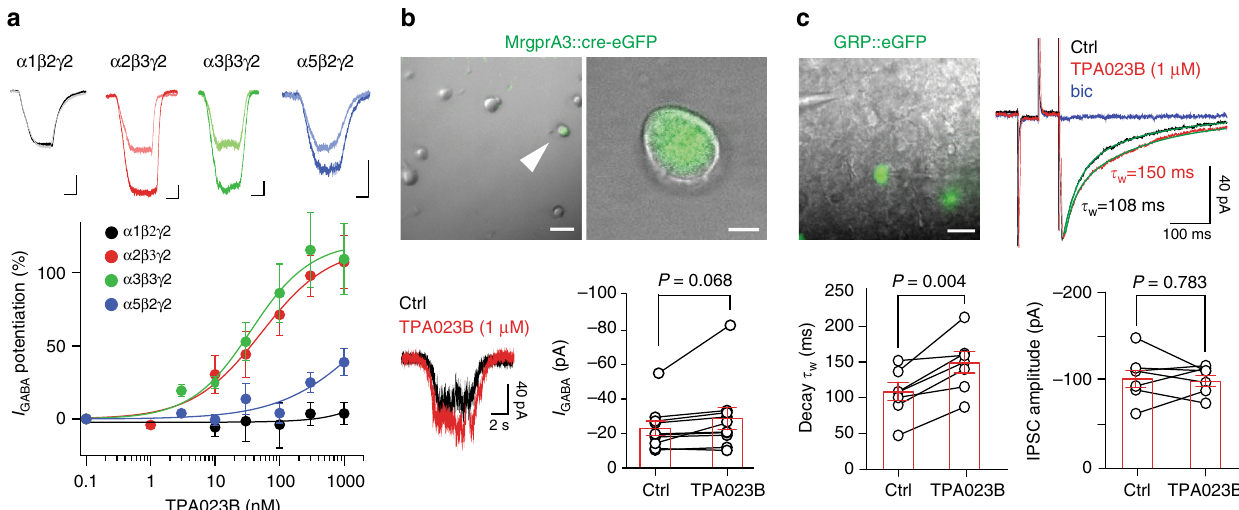
Fig. 4 In vitro pharmacological pro fi le of TPA023B. a Positive allosteric modulation by TPA023B of α 1 β 2 γ 2, α 2 β 3 γ 2, α 3 β 3 γ 2, and α 5 β 2 γ 2 GABA A Rs in HEK293 cells transiently transfected with the respective GABA A R subunits. Current traces (top) evoked by exogenous application of GABA at EC 5 . Light traces, control; bold traces, TPA023B (1 µ M). Scale bars, 2 s, 200 pA. n = 6, for α 2 β 3 γ 2, n = 5 for all other subtypes. b Potentiation of GABA A R currents in MrgprA3::cre-eGFP positive lumbar DRG neurons. Top: micrographs. Superposition of eGFP fl uorescence and phase contrast image. Scale bars, 50 µ m (left) and 10 µ m (right). Bottom: examples of current traces under control conditions (black) and in the presence of TPA023B (1 µ M) (red). Statistical analyses: GABAergic current amplitudes. Paired two-sided t -test; n = 10. c Potentiation of GABAergic inhibitory postsynaptic currents (IPSCs) in transverse spinal cord slices. Top left: Superposition of eGFP fl uorescence and infrared gradient contrast in lamina II with two GRP::eGFP positive neurons, the recording patch pipette (right) and the stimulation electrode (left). Scale bar, 20 µ m. Top right: Examples of GABAergic IPSCs (averages of 10 consecutive current traces) recorded under control conditions (ctrl, black), in the presence of TPA023B (red) and bicuculline (bic 10 µ M, blue). Superimposed in green are fi ts to double exponential functions. (bottom) Statistical analyses. Changes in the weighted time constants ( τ w ) of IPSC decay and IPSC amplitudes. Bars and error bars (red) are mean ± s.e.m.. P values have been obtained from paired two-sided t -tests. n = 7 for both analyses. Error bars indicate